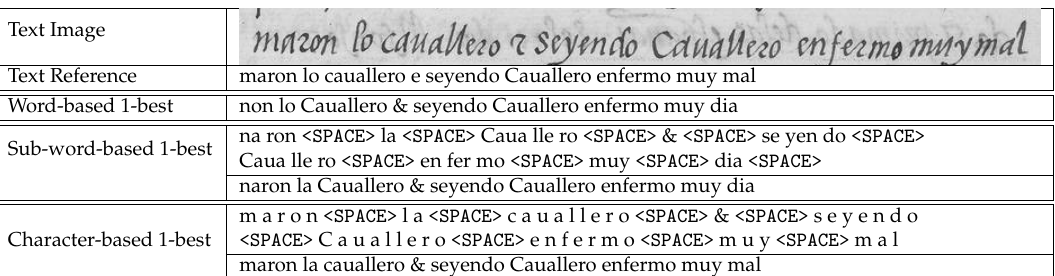
Figure A3. Example of the best hypotheses obtained for the 4th line of page 514 of Rodrigo